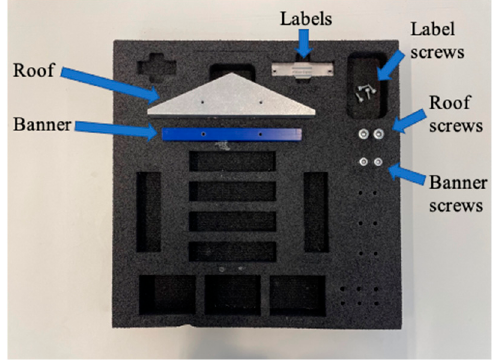
Figure 3. Component box containing spare parts for the assembly.